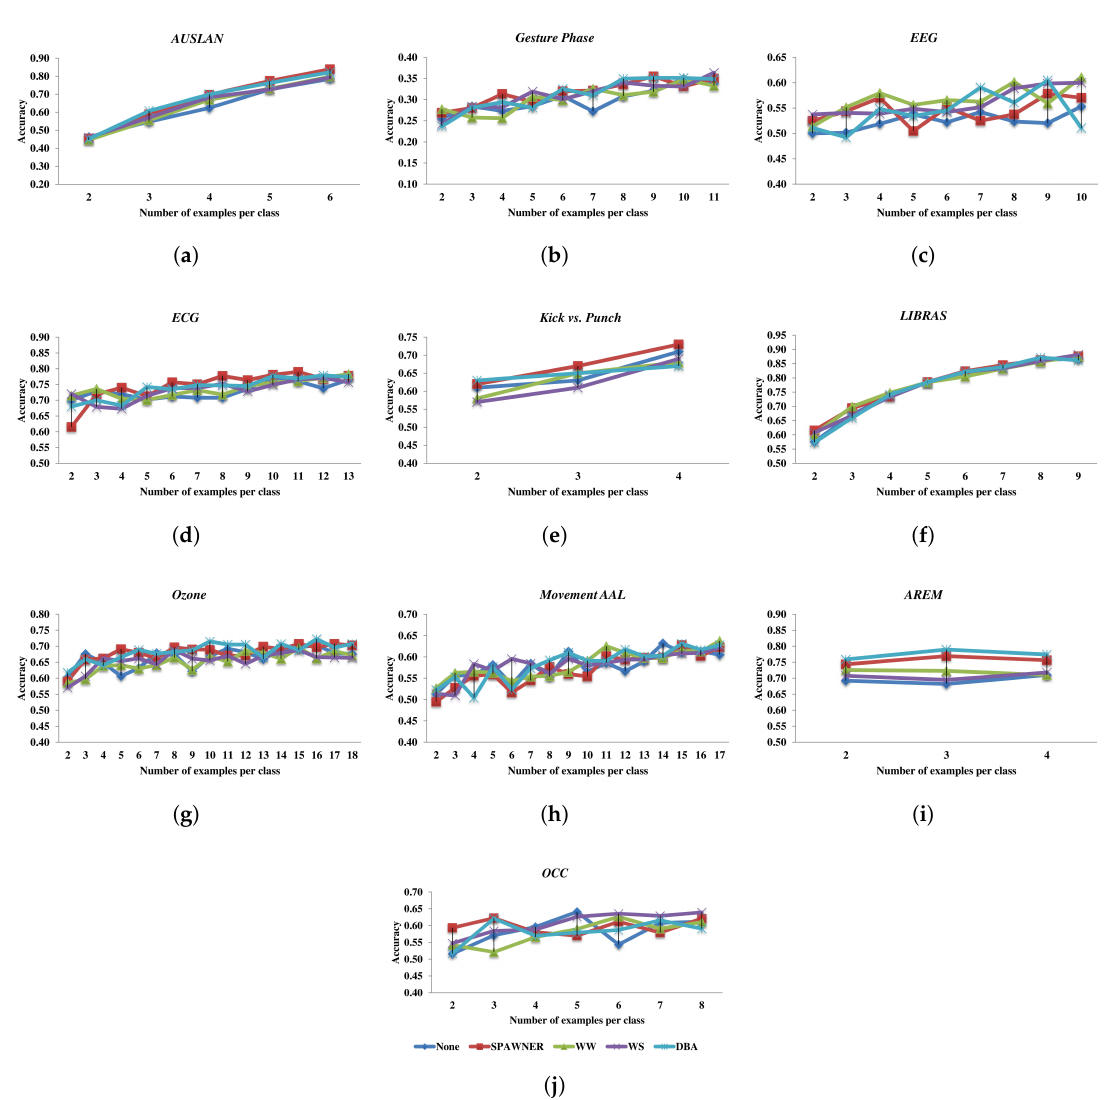
Figure 3. Accuracy of NN-DTW classifier with augmented small number of examples per